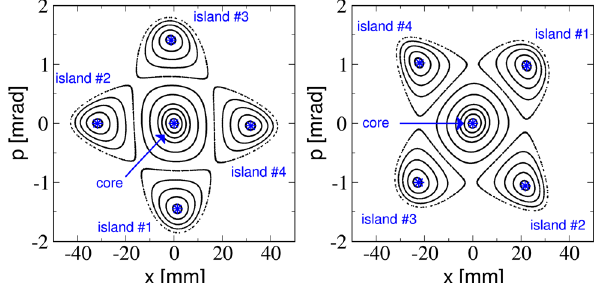
FIG. 2. Examples of horizontal phase space portraits at two different locations of the CERN PS ring in the presence of stable islands of fourth-order resonance. Blue stars denote the fixed points, which rotate in phase along the ring as in Fig.